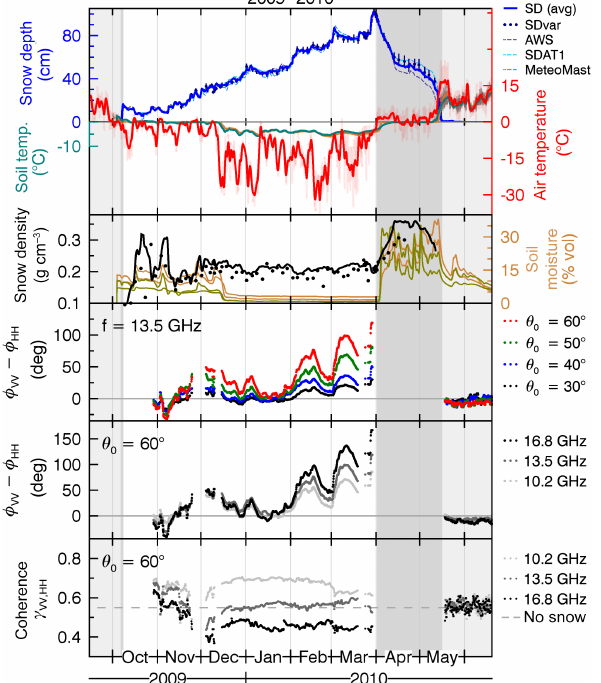
Figure 7. Winter season 2010–2011. Meteorological and radar data as shown in Fig. 6 and described in Sect. 4.6. The vertical dashed line shows the date when the snow profile CT-1 was